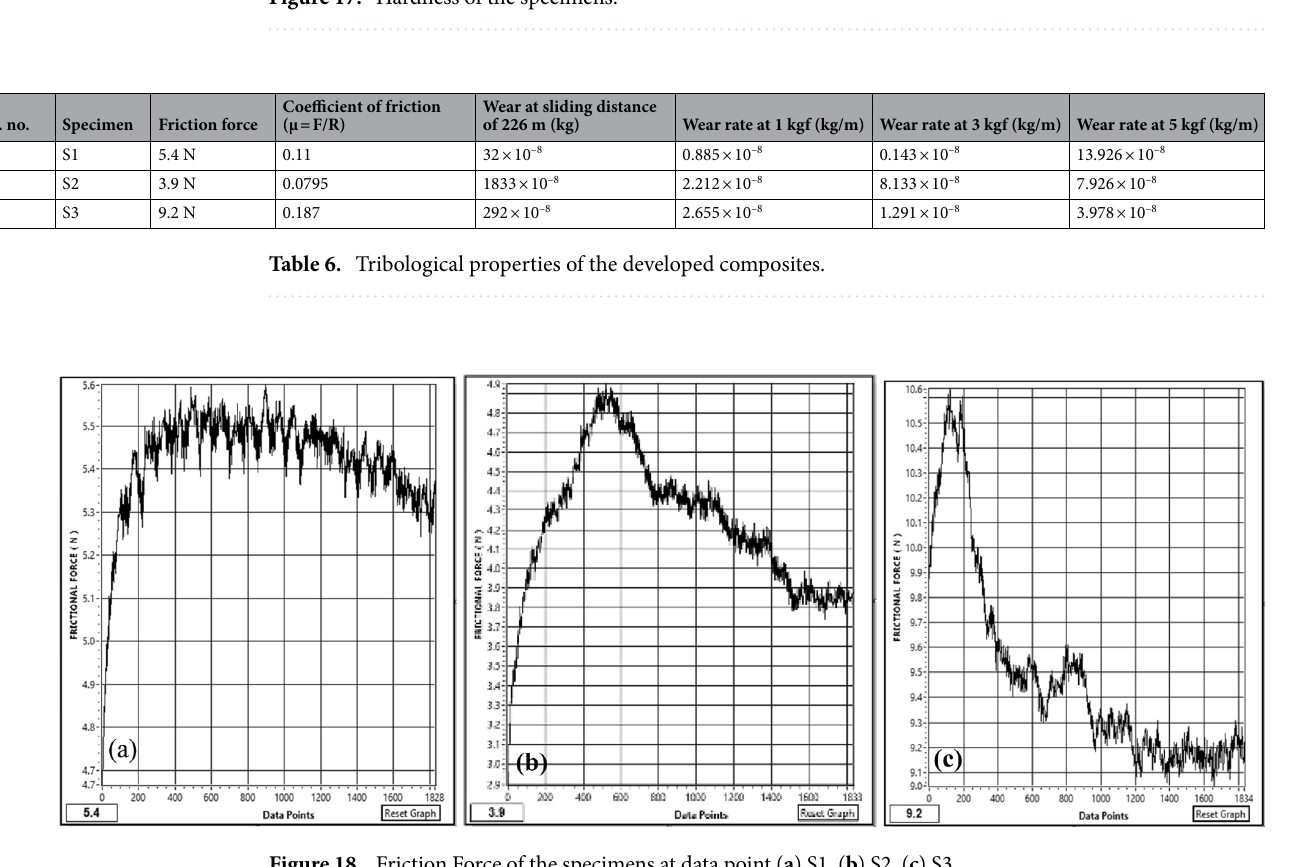
Figure 17. Hardness of the specimens.